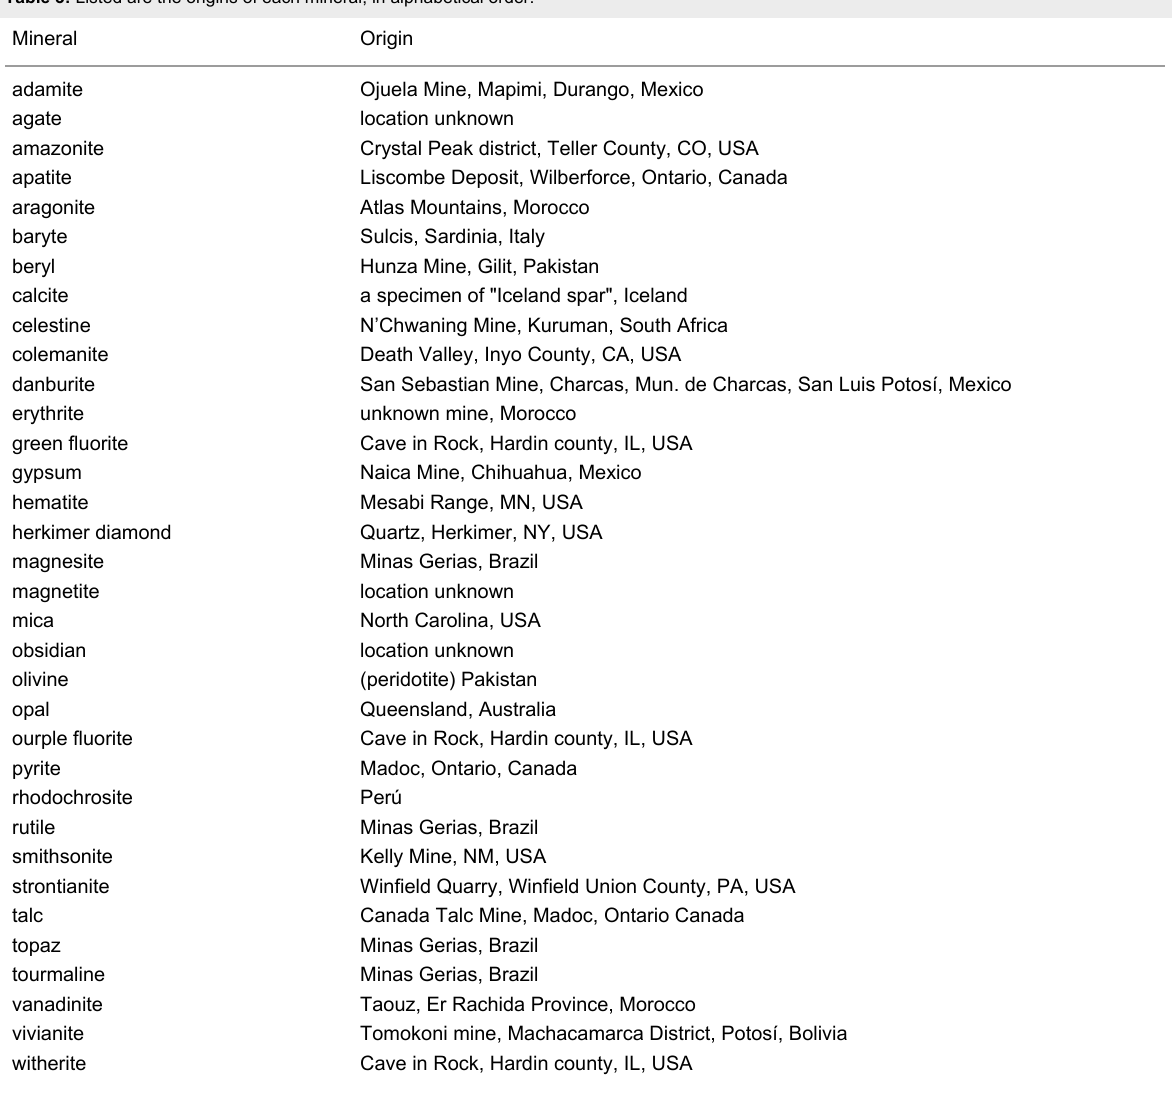
Table 3: Listed are the origins of each mineral, in alphabetical order. Mineral